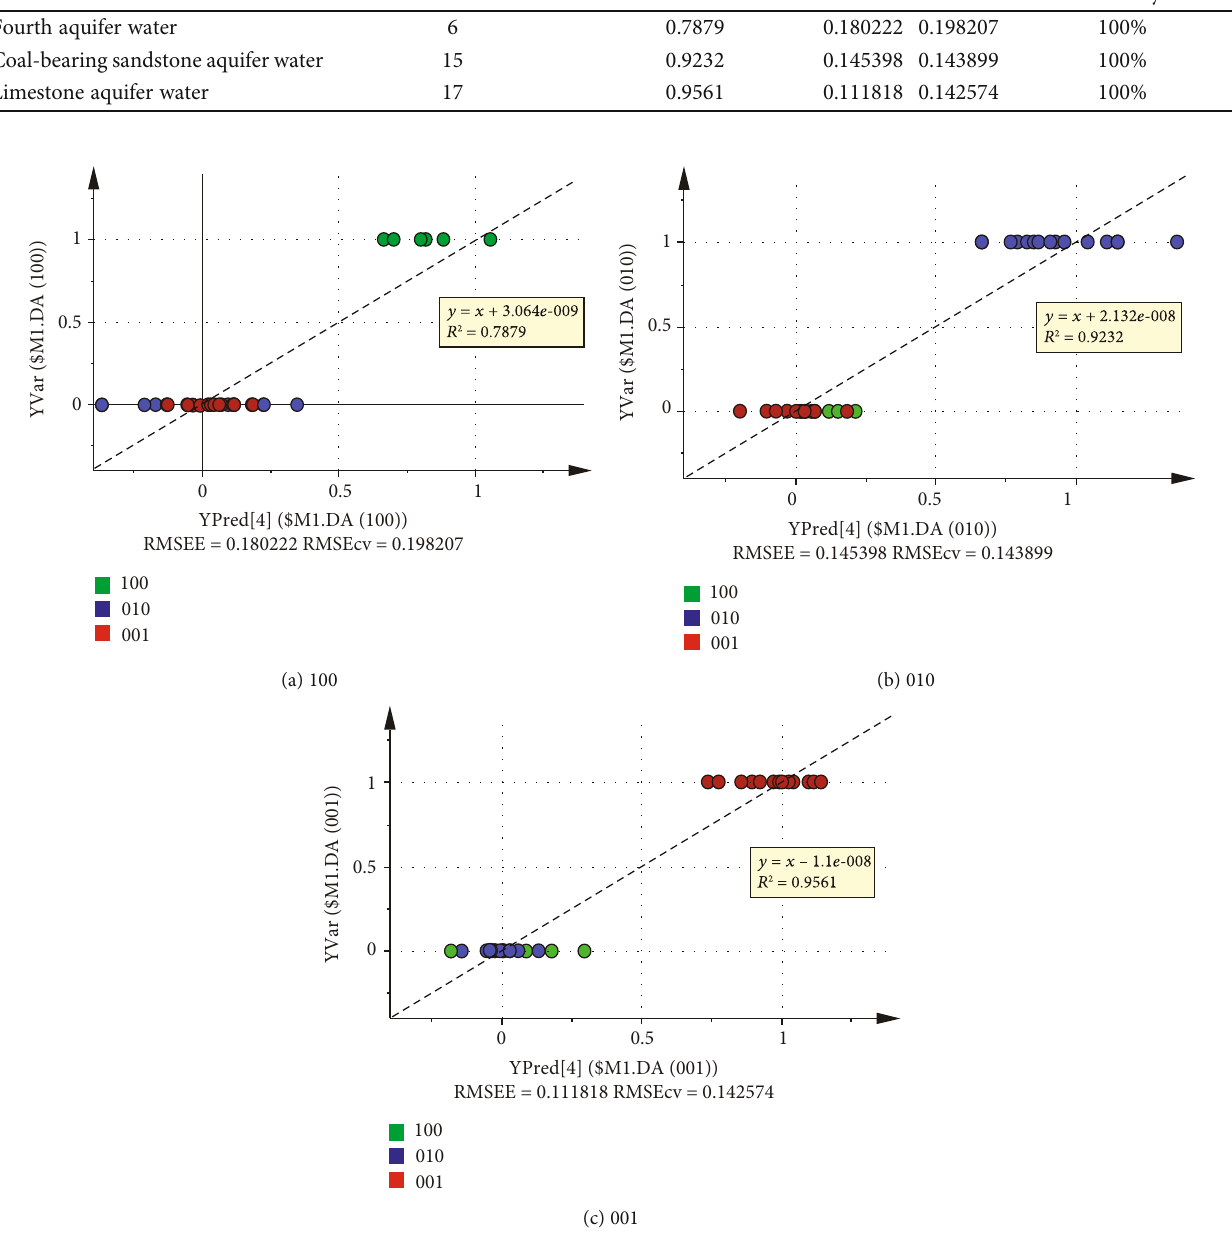
Figure 11: The regression diagrams for PLS predicted and actual values of the categorical variables from the PLS-DA model training set. 100: fourth aquifer water; 010: coal-bearing sandstone aquifer water; 001: limestone aquifer